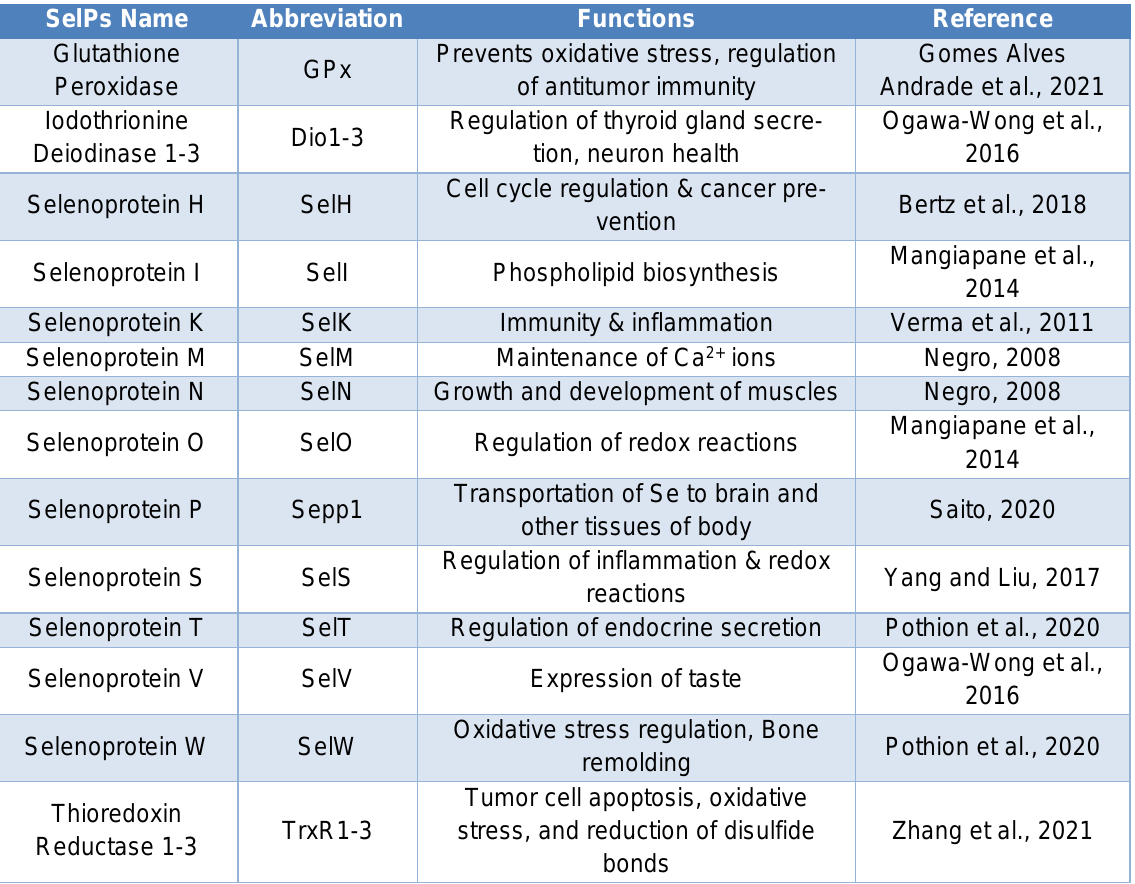
Table 1: Mammalian Selenoproteins (SelPs) and their functions in the